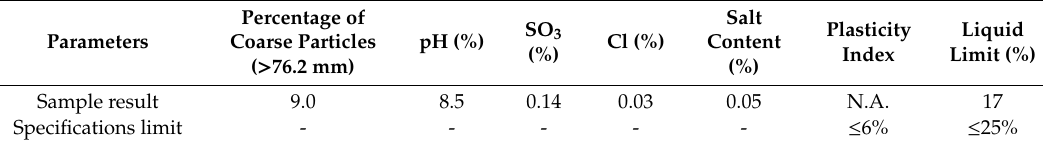
Table 1. Specifications of the onsite soil (taken from the laboratory of the plant according to ASTM D4318-17e1 and ASTM